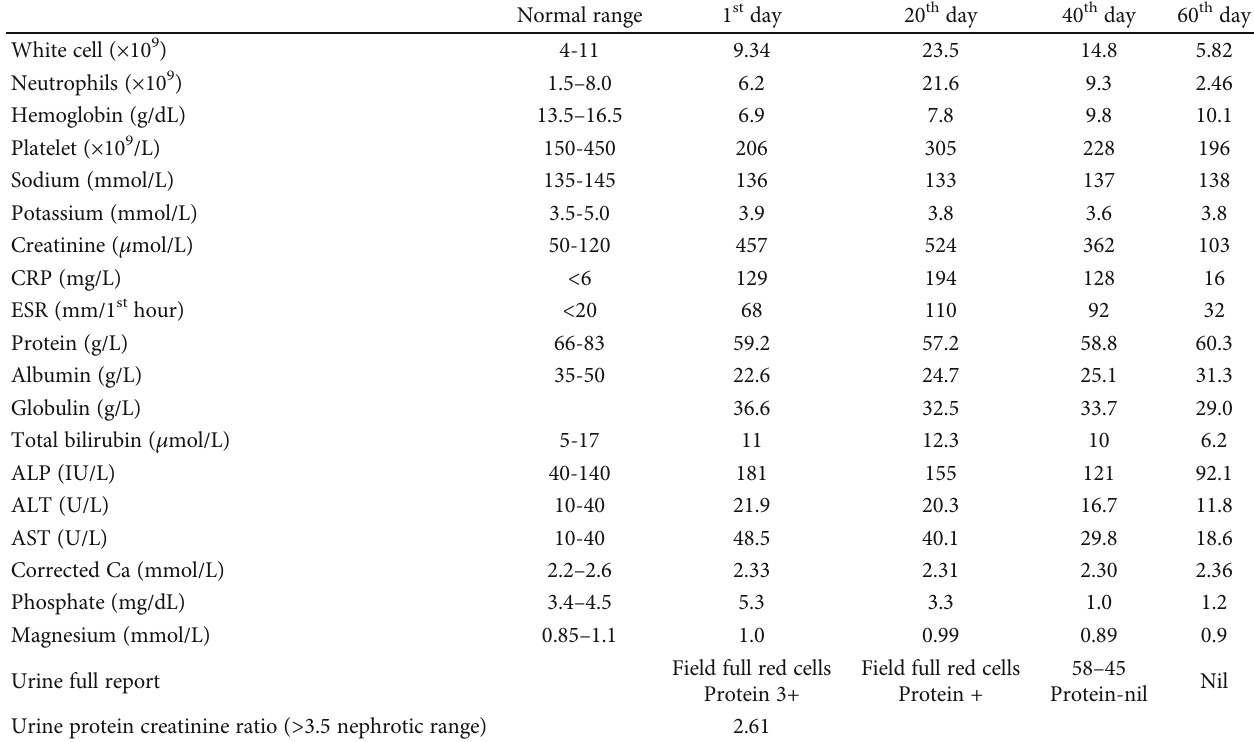
Table 1: Summary of basic investigations.